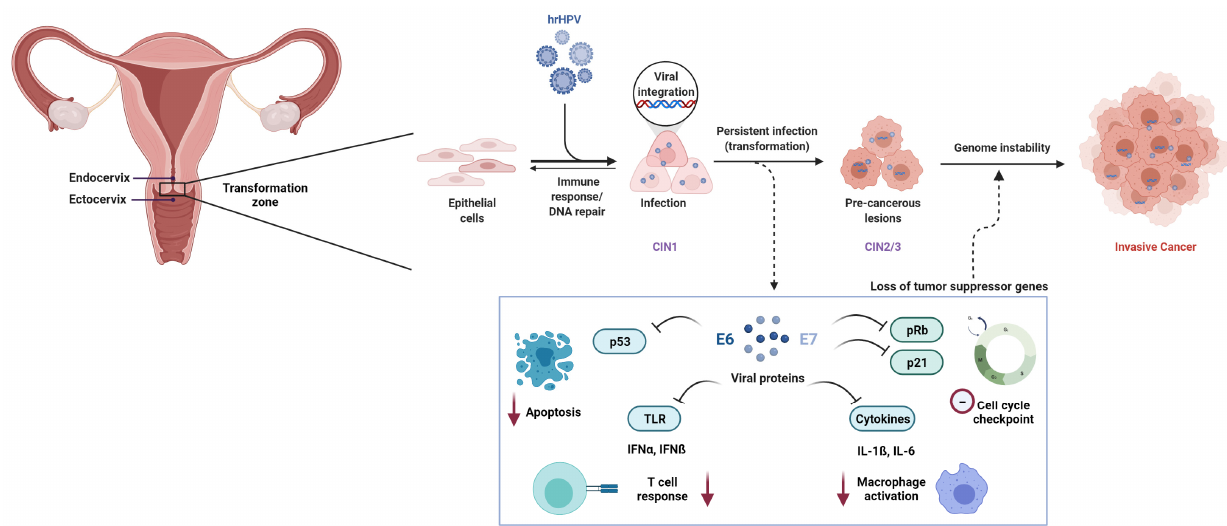
Figure 1. Pathogenesis of cervical cancer. Epithelial cells in the transformation zone of the cervix acquire lesions upon persistent infection with high risk HPV (hrHPV). In some cases, the lesions resolve, whereas in others, upon viral integration, cells are transformed and progress from cervical intraepithelial neoplasia I to II and III (CIN1, CIN2, and CIN3). Viral proteins E6 and E7 are released and inhibit apoptosis mediated by TP53, cell cycle checkpoint by p21, T-cell response by toll-like receptors (TLR), and macrophage activation by cytokines. This leads to an insufficient immune response and viral replication, uncontrolled cell proliferation and genome instability, and further cancer in situ (CIS) or invasive cervical cancer (CC).